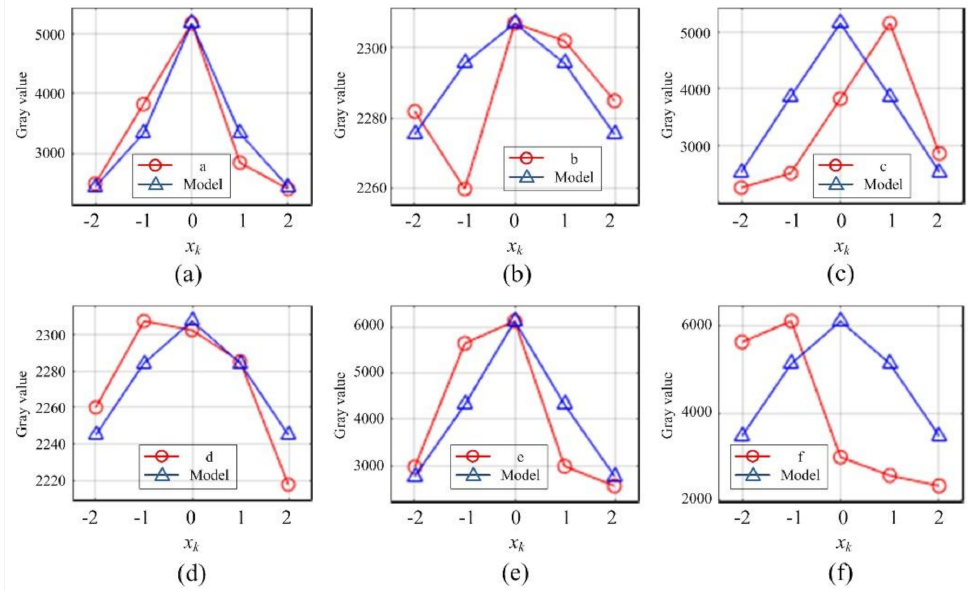
Figure 3. Image data and fitting models in six positions of Ob 1 and Ob 2 (pixel ( a – f